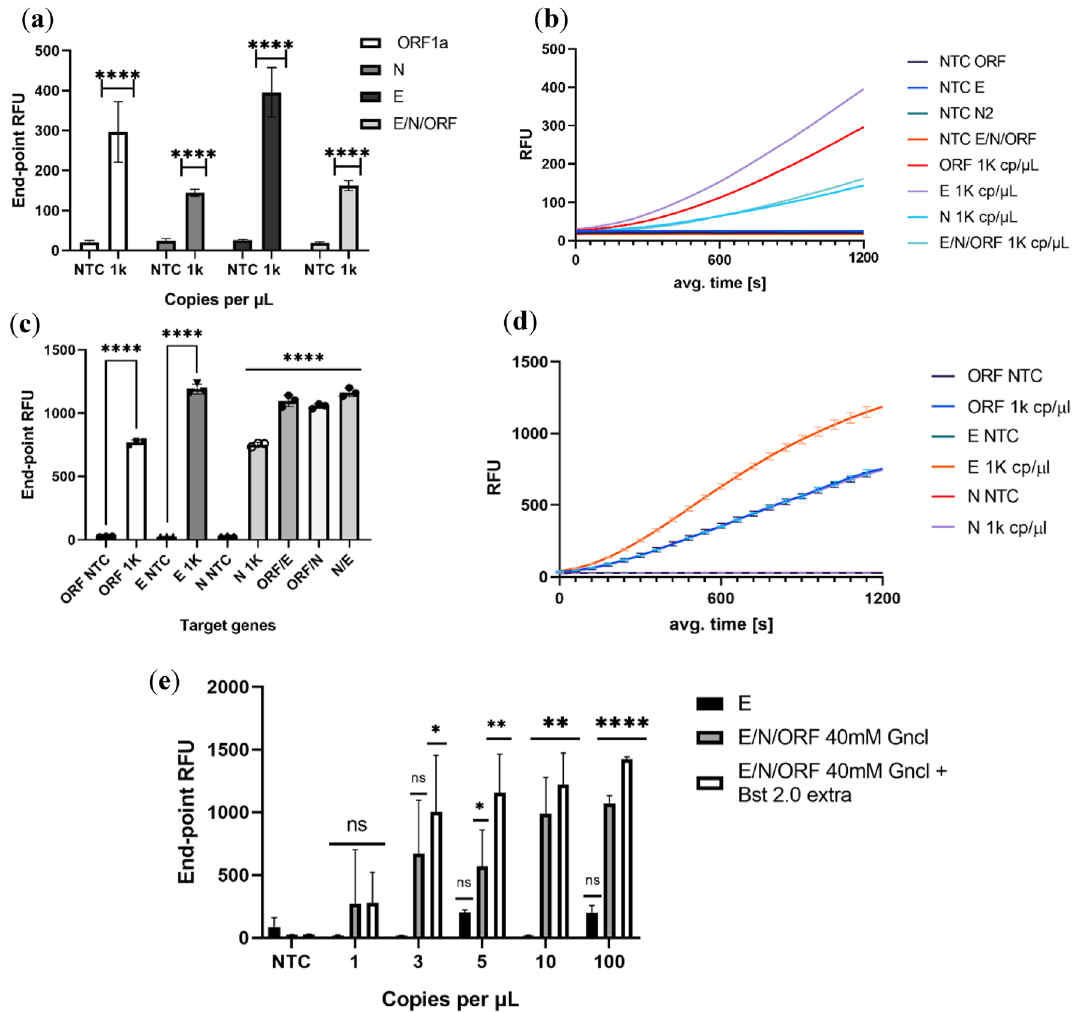
Figure 3. Detection of Sars-CoV-2 in the Cas12a reaction (2 step reaction). ( a ). End point fluorescence of the non-optimized reaction and the respective kinetics ( b ). ( c ) Detection of individual genes amplified by RT-LAMP by Cas12a using the optimized version and respective kinetic profile ( d ). ( e ) Limit of detection using a 3-primer set with guanidine hydrochloride and with extra Bst 2.0 polymerase. Statistical significance was determined by unpaired two-tailed t-test and all data were shown as mean ± S.D of 3 replicates. Asterisks indicate **P < 0.01; ***P < 0.001; ****P < 0.0001 and “ns” is